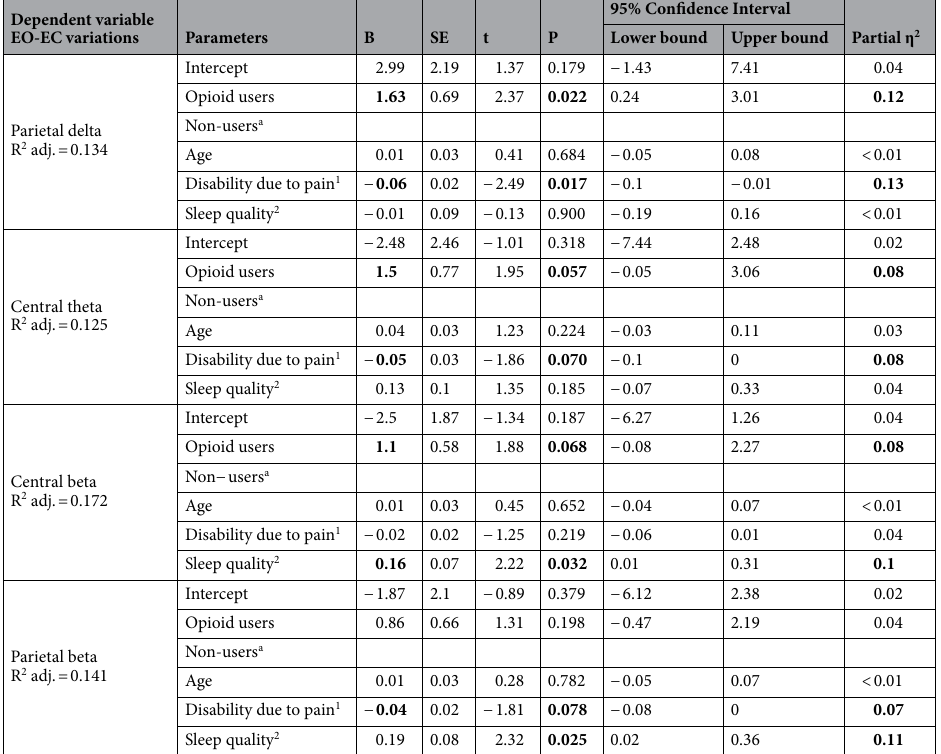
Table 5. Parameter estimates of the Multivariate analysis of covariance (MANCOVA) model used to explain SPD peak amplitudes using Group, age, disability due to pain and sleep quality as factors (total n = 47). Bold values indicates statistically significant effects (P < 0.05) and marginally non-significant effects. EO = eyes open; EC = eyes closed; SE = standard error. a = reference group for comparisons. 1 = indexed by B-PCP:S = Brazilian Profile of Chronic Pain: Screen (total score). 2 = indexed by PSQI = Pittsburgh Sleep Quality